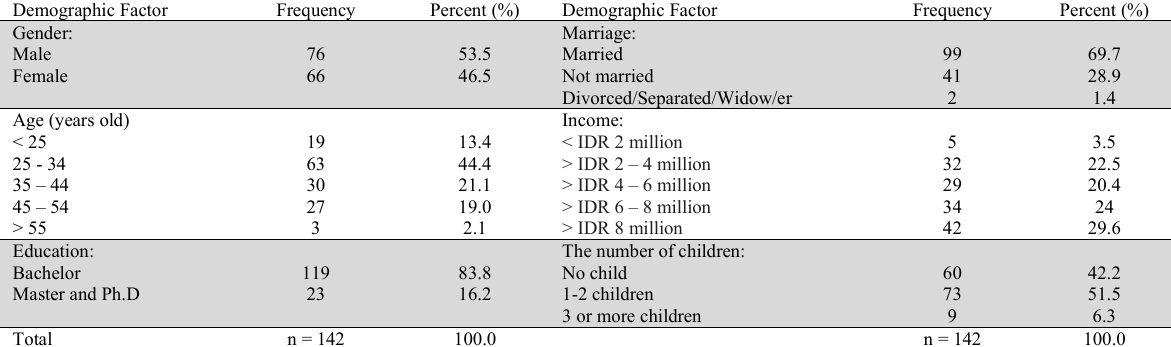
Sample Characteristic Based on Demographic